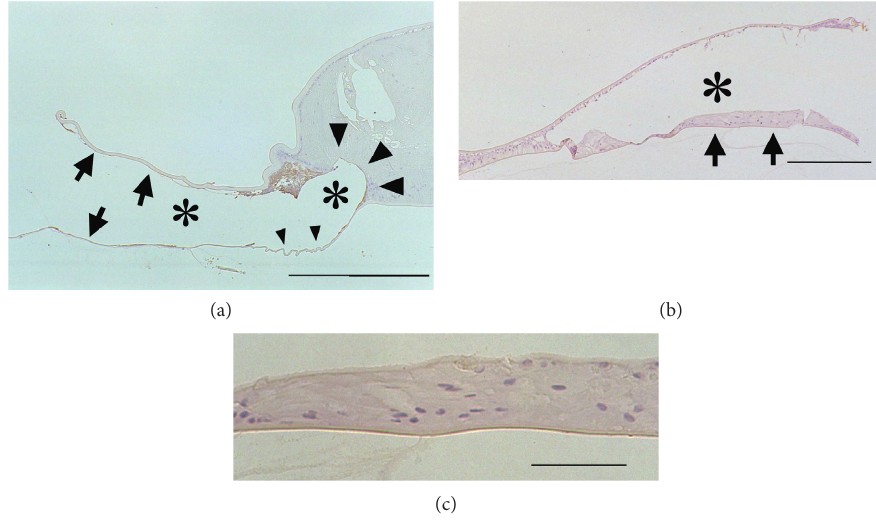
Figure 4: Immunolocalization of α -SMA in pseudophakic rabbit eyes 14 days after cataract surgery. (a) Surrounding type: most of the capsules around the IOL optics are devoid of LECs (arrows). Some posterior capsules are wrinkled without LECs (small arrowheads). Some α -SMA-positive LECs are present on the capsules, and the Soemmering ring has increased in size. The separation between the IOL optic and the Soemmering ring is lost. Part of the Soemmering ring has begun to attach to the IOL optic (large arrowheads). Bar � 200 μ m. (b) Restricted type: the differentiation of LECs under the IOL optic has progressed to form the Elschnig pearls type of opacification (arrows). Bar � 200 μ m. (c) Higher power view of (b): the differentiated lens fiber cells are recognizable. Bar � 50 μ m. (a–c) Sections were stained with 3-3’-diaminobenzidine hydrochloride and counterstained with hematoxylin. Asterisks indicate the IOL